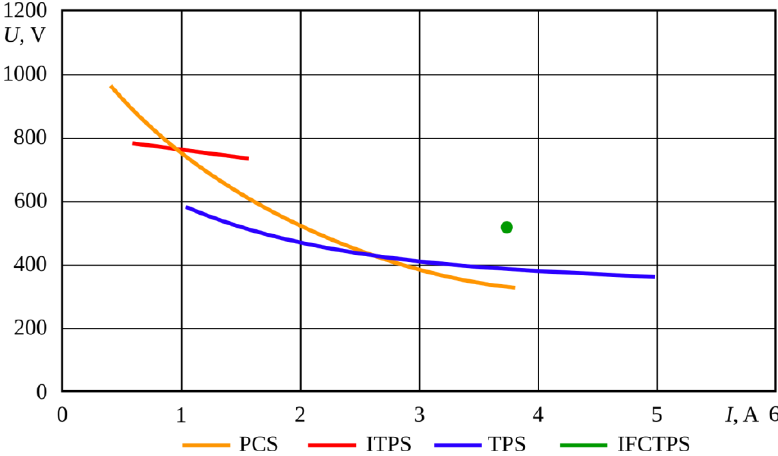
Figure 14. Control characteristics of the tested power supplies loaded with plasma reactor, plasma gas: nitrogen, volumetric flow rate: 1.6 m 3 /h.